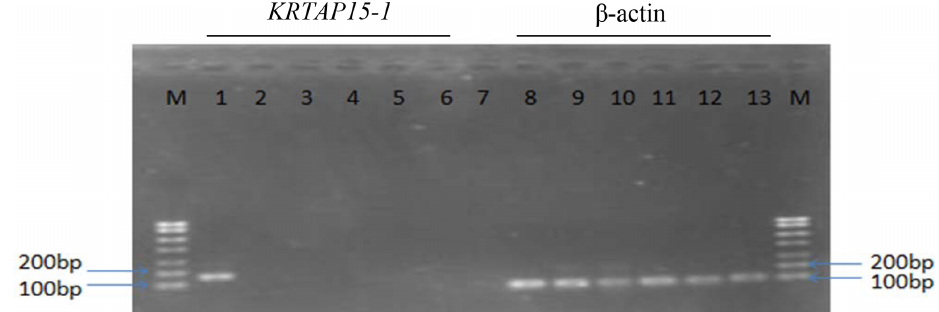
Figure 5. RT-PCR results for detection of β -actin and KRTAP15-1 in six tissues derived from Longdong cashmere goats. M: 750bp DNA marker; lanes 1 and 8: secondary hair follicle tissue; lanes 2 and 9: heart tissue; lanes 3 and 10: liver tissue; lanes 4 and 11: lung tissue; lanes 5 and 12: kidney tissue; lanes 6 and 13: longissimus dorsi muscle tissue; lane 7: negative control. Table 1. Association of caprine KRTAP15-1 variants with cashmere traits (mean ± SE). ∗ Trait (unit) Variant Absent Present P value Mean ± SE n Mean ± SE n Cashmere yield (g) A 417 ± 6 . 0 74 418 ± 4 . 8 157 0.861 B 420 ± 5 . 3 117 415 ± 5 . 1 114 0.357 C 419 ± 5 . 1 119 416 ± 5 . 2 112 0.509 Crimped fibre length (cm) A 4 . 2 ± 0 . 06 74 4 . 3 ± 0 . 05 157 0.126 B 4 . 3 ± 0 . 06 117 4 . 3 ± 0 . 06 114 0.487 C 4 . 3 ± 0 . 55 119 4 . 2 ± 0 . 56 112 0.110 Mean fibre diameter (µm) A 13 . 6 ± 0 . 06 74 13 . 4 ± 0 . 05 157 0.006 B 13 . 4 ± 0 . 05 117 13 . 4 ± 0 . 05 114 0.997 C 13 . 4 ± 0 . 05 119 13 . 5 ± 0 . 05 112